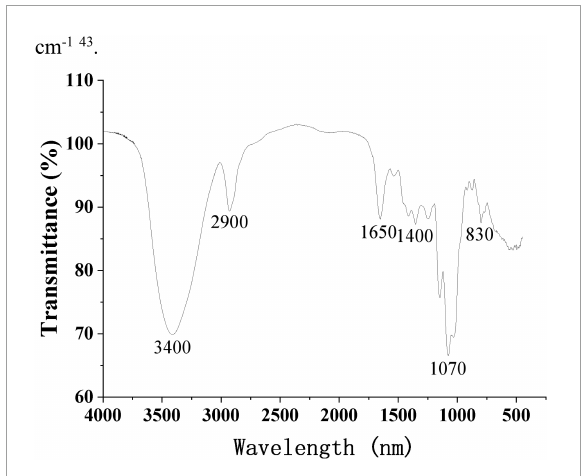
FIGURE5 FT-IR spectrum of SRF-3. OMNIC spectral analysis software was used to perform analysis and processing of FT-IR spectral data.